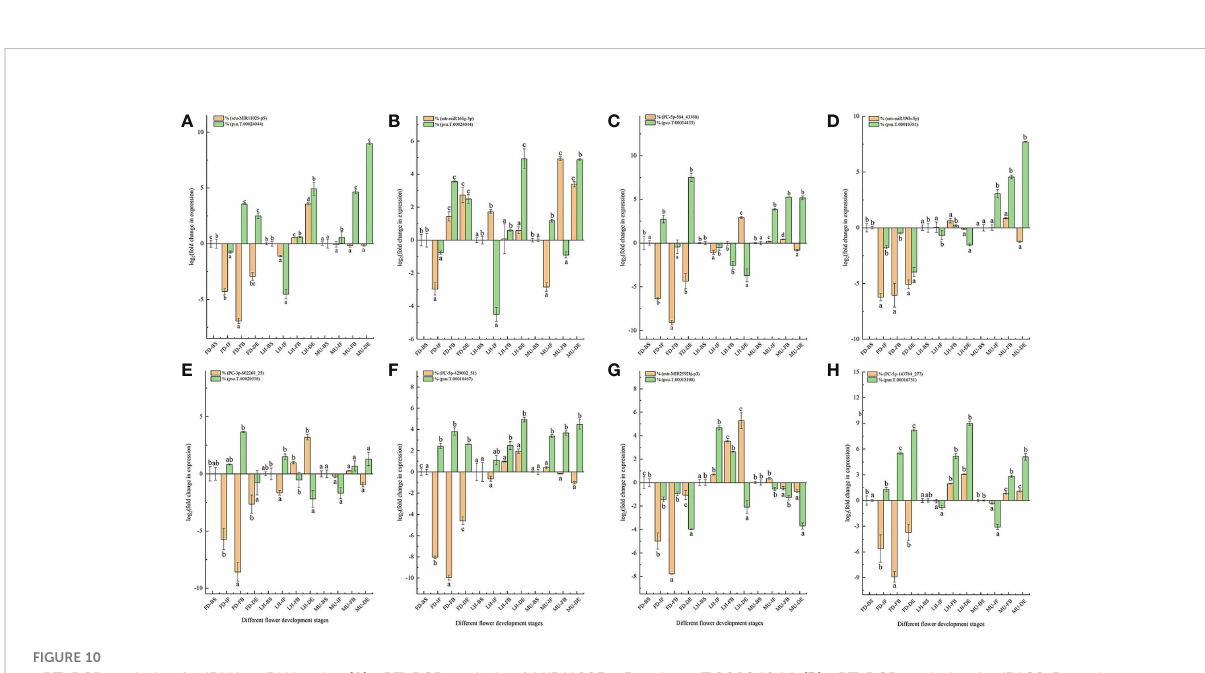
FIGURE 10 qRT-PCR analysis of miRNA-mRNA pairs. (A) qRT-PCR analysis of MIR11025-p5 and psu.T.00024044 . (B) qRT-PCR analysis of miR166-5p and psu.T.00024044 . (C) qRT-PCR analysis of PC-5p-564_43386 and psu.T.00034433 . (D) qRT-PCR analysis of mtr-miR396b-5p and psu.T.00010381 . (E) qRT-PCR analysis of PC-3p-602268_25 and psu.T.00020538 . (F) qRT-PCR analysis of PC-5p-429002_51 and psu.T.00018467 . (G) qRT-PCR analysis of mtr-MIR2592bj-p3 and psu.T.00015108 . (H) qRT-PCR analysis of PC-5p-143784_277 and psu.T.00016751 . MU, Mutant of Paeonia ostii ‘ Fengdan ’ ;